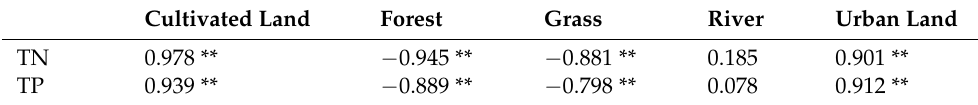
Table 4. Pearson correlation analysis between the land-use changes and TN/TP load. Cultivated Land Forest Grass River Urban Land